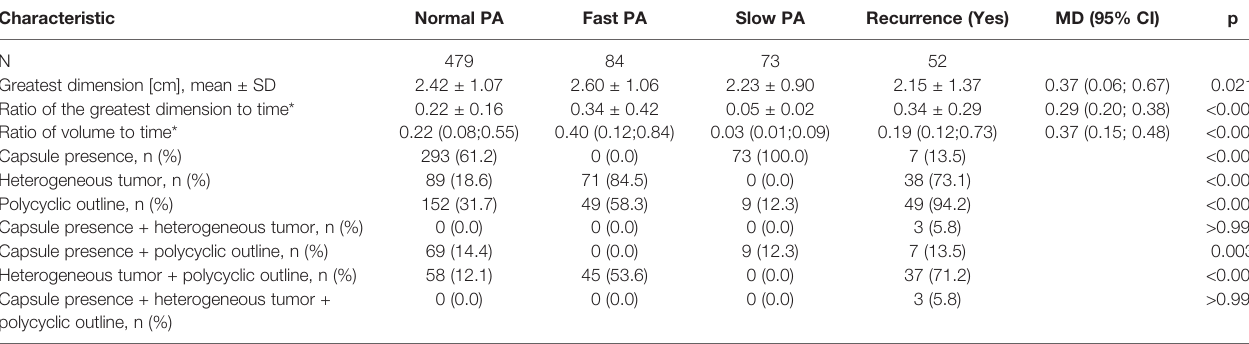
TABLE 1 | Comparison of criteria determining fast and slow PA categorization. Characteristic